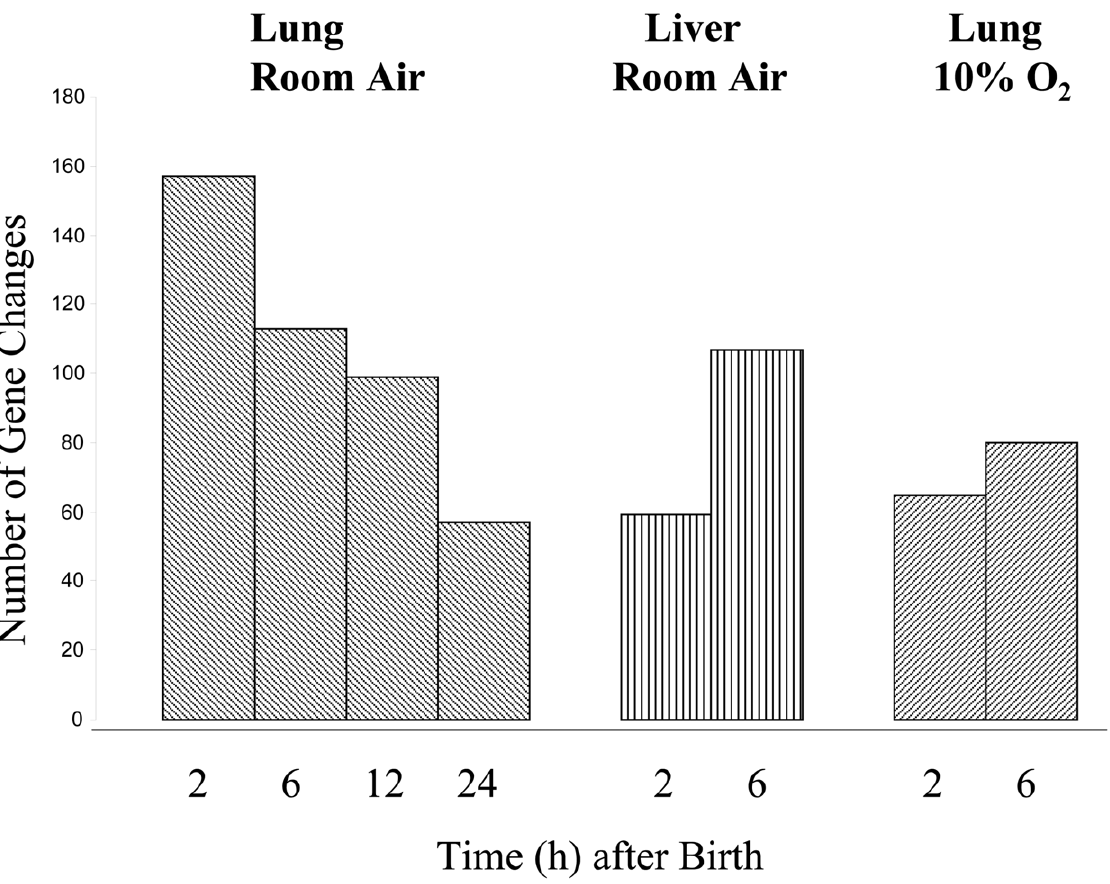
Figure 2. Number of genes changing their level of expression at birth. In the lung birthed in room, the greatest number of gene changes (157) was at 2 h and transcriptional regulation, structure, apoptosis and antioxidant activity were overrepresented functional categories. Thereafter the numbers declined to 113, 99 and 57 at 6 h, 12 h and 24 h, respectively. In the liver birthed in room air, there were only 59 gene changes at 2 h and 100 at 6 hr. In the lung birthed into 10% oxygen, there were only 65 gene changes at 2 h and 80 at 6 h. No functional category of gene expression was overrepresented in either dataset.